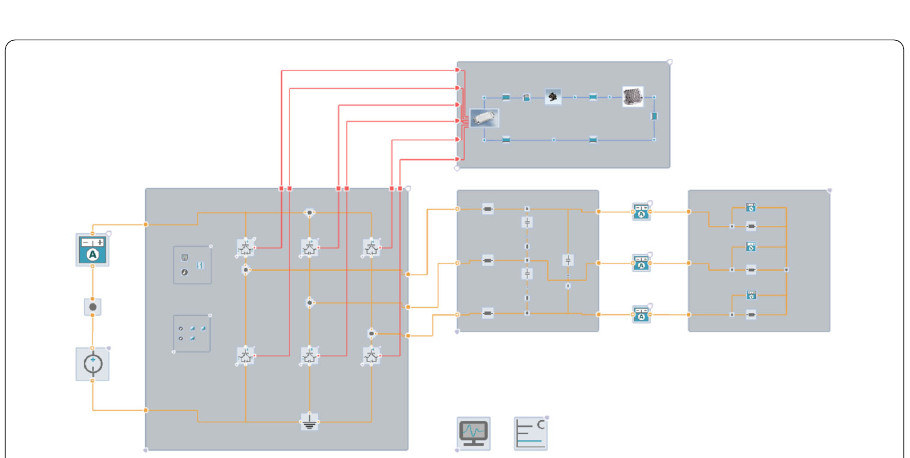
Figure 6 Schematic representation of a three-phase inverter with cooling system in AVL CRUISE™M. The corresponding results are displayed in Fig. 7–8 and Table 2 for BEV with cooling system